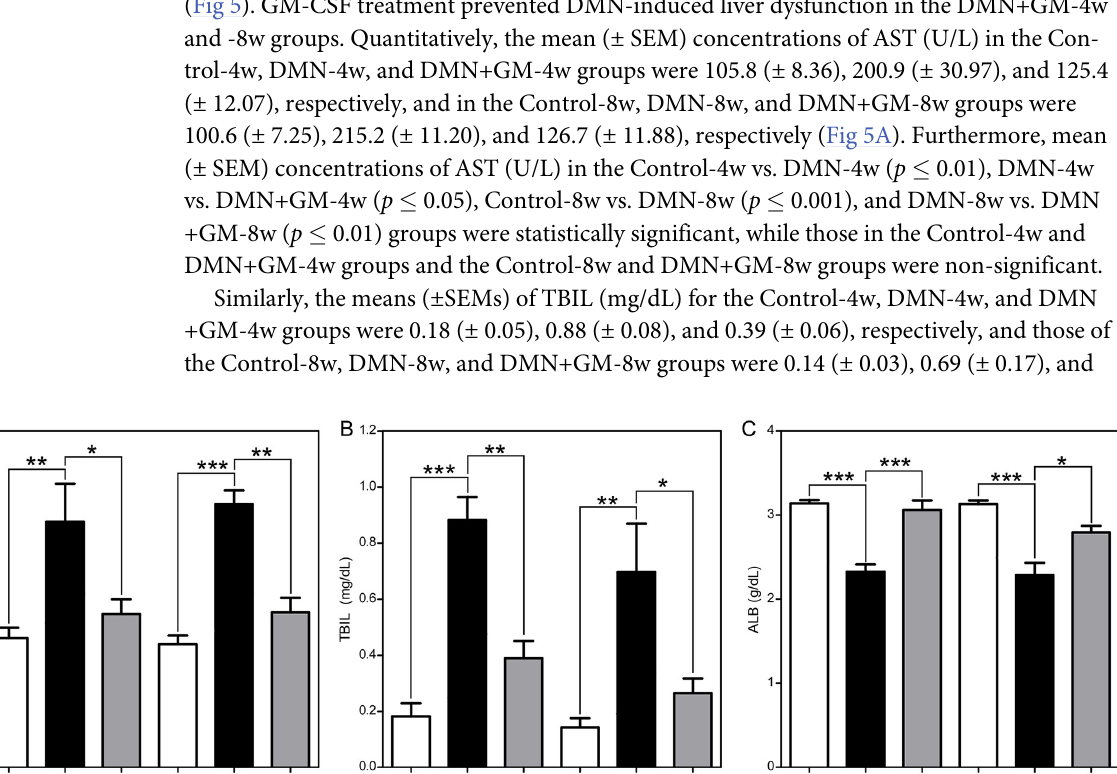
PLOS ONE | https://doi.org/10.1371/journal.pone.0274126 September 2,